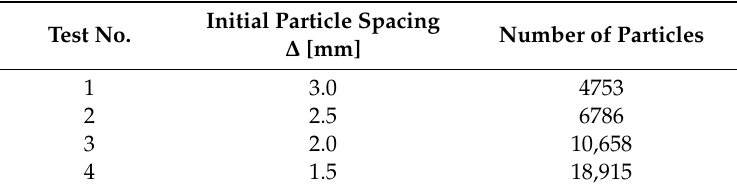
Table 1. Parameters of particle spacing.